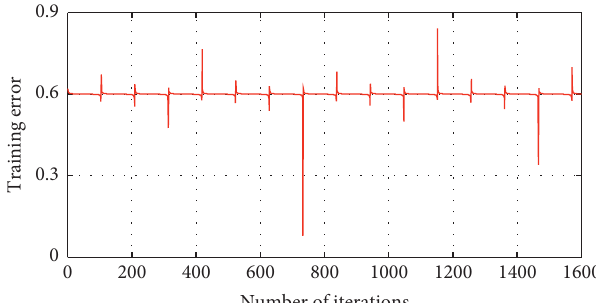
Figure 5: 3D visual image experiment of aerobics movement 1 training error.